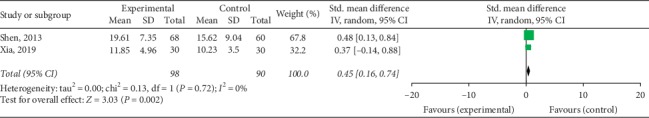
Forest plot for PSV of ovarian stromal blood between TKABP and control group.